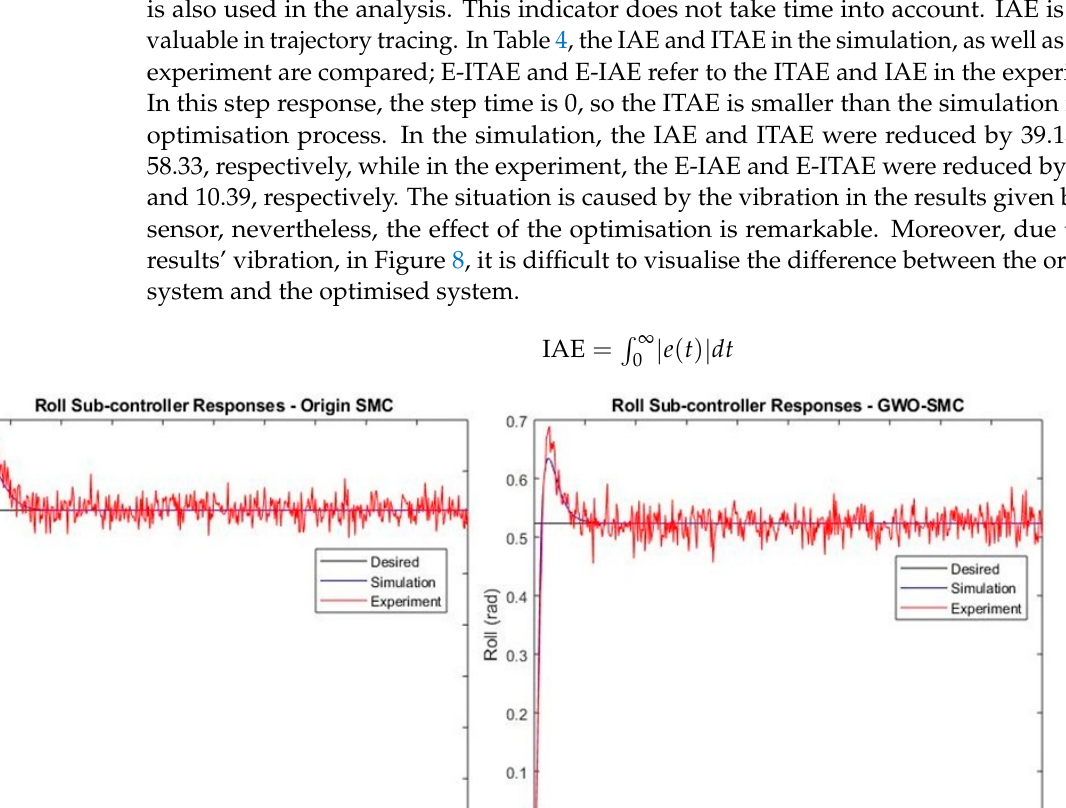
Table 5. Performance of the optimised roll sub ‐ controller .